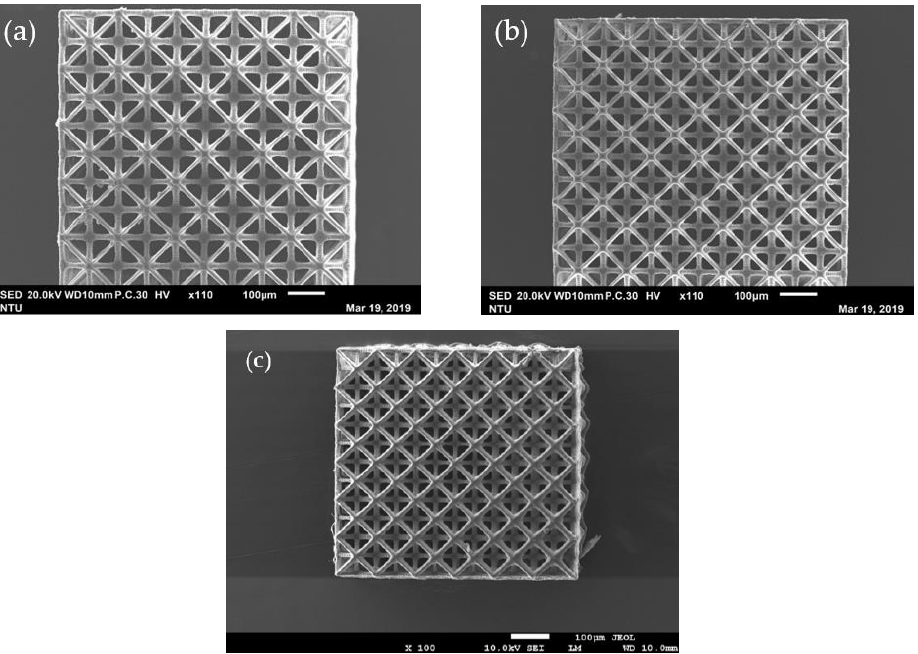
Figure 3. Top view of micro-lattice structures with unit cell length (L) of ( a ) 150 µ m; ( b ) 130 µ m; ( c ) 100 µ m. Table 1. The design and actual dimensions of truss elements for the 3 unit cell sizes printed.